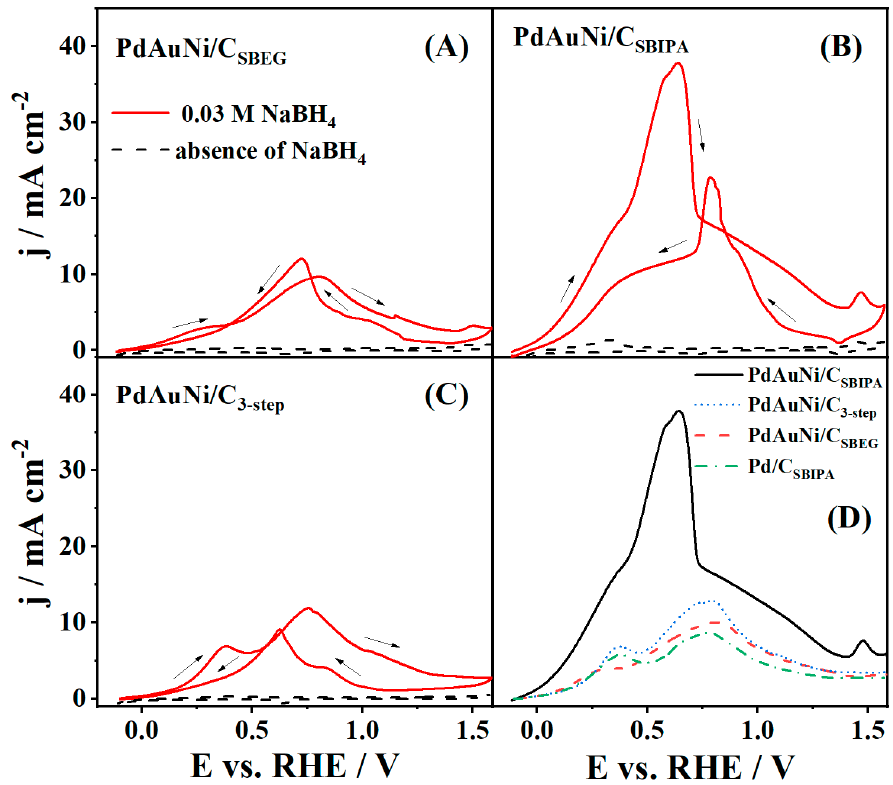
Figure 6. CVs (third cycle) in the absence (2 M NaOH) and presence (2 M NaOH + 0.03 M NaBH 4 ) of BH 4 − for ( A ) PdAuNi/C SBEG , ( B ) PdAuNi/C SBIPA , and ( C ) PdAuNi/C 3-step electrocatalysts, and ( D ) comparative CVs of trimetallic and Pd/C SBIPA monometallic catalysts in the presence of BH 4 − . CVs ran at 50 mV s − 1 and 25 °C.